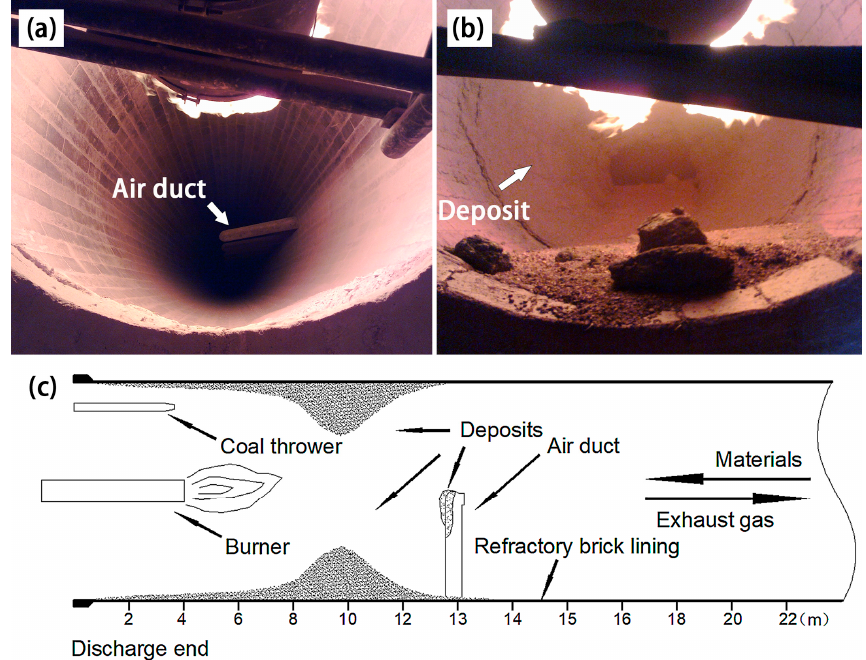
Figure 2. Digital photos of internal view of the Φ 4 m × 60 m limonite magnetization reduction roasting (MRR) rotary kiln: ( a ) without deposit; ( b ) with serious deposits; ( c ) cross section schematic of the